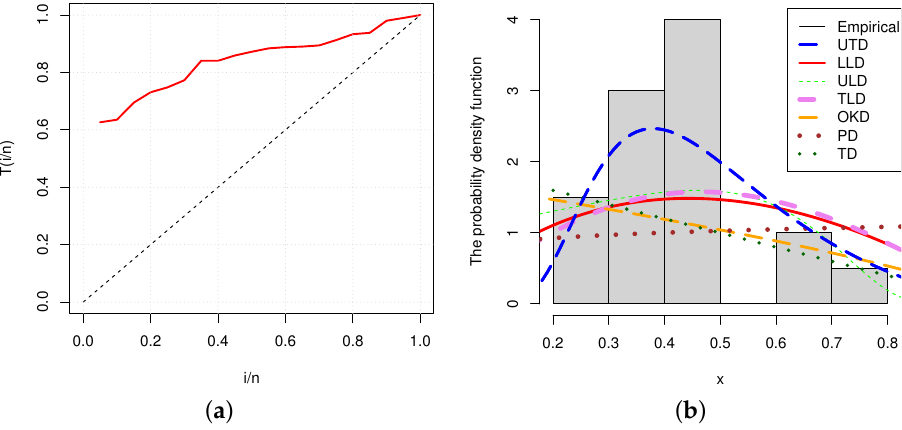
Figure 5. ( a ) TTT plot and ( b ) histogram for the flood level data.